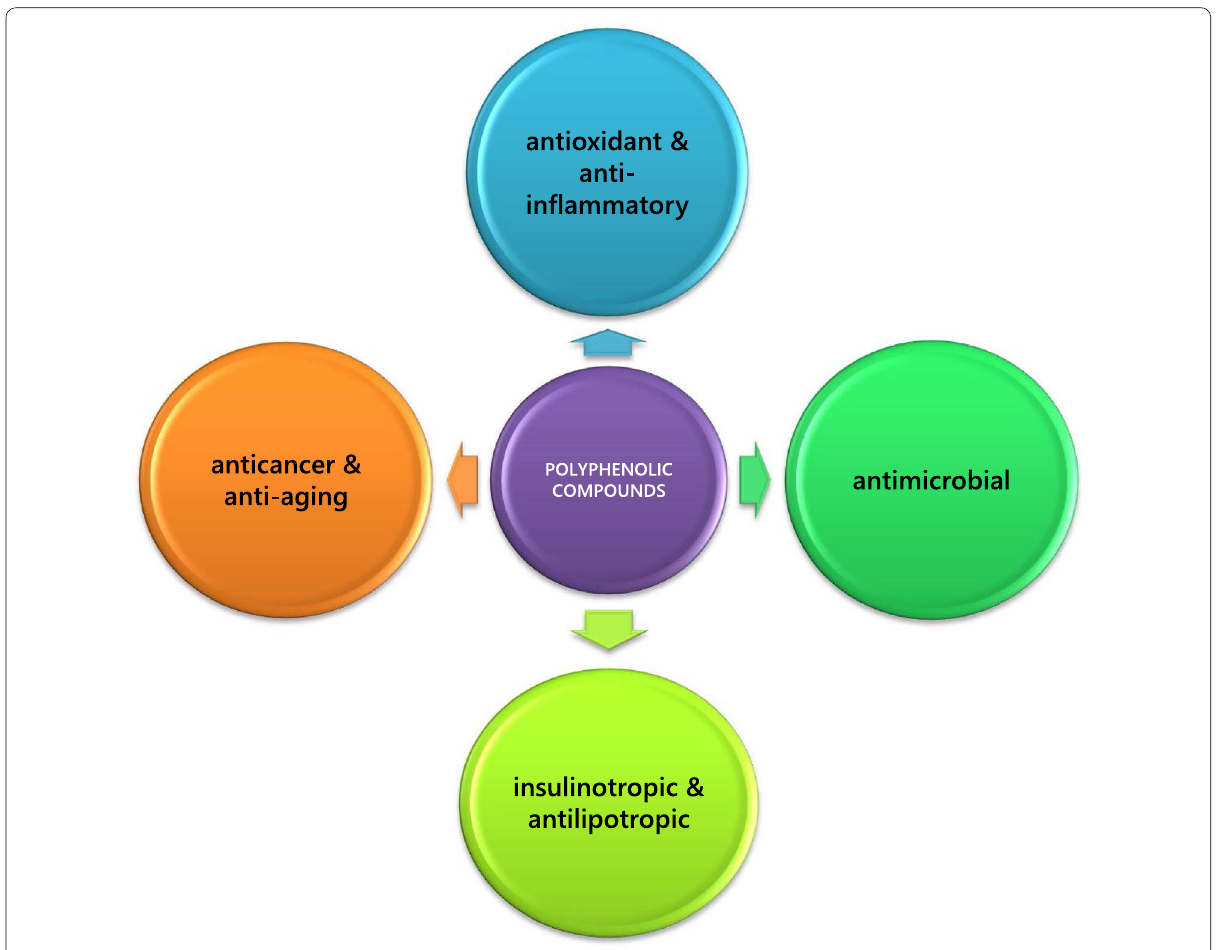
Fig. 5 Biological effects of polyphenolic molecules